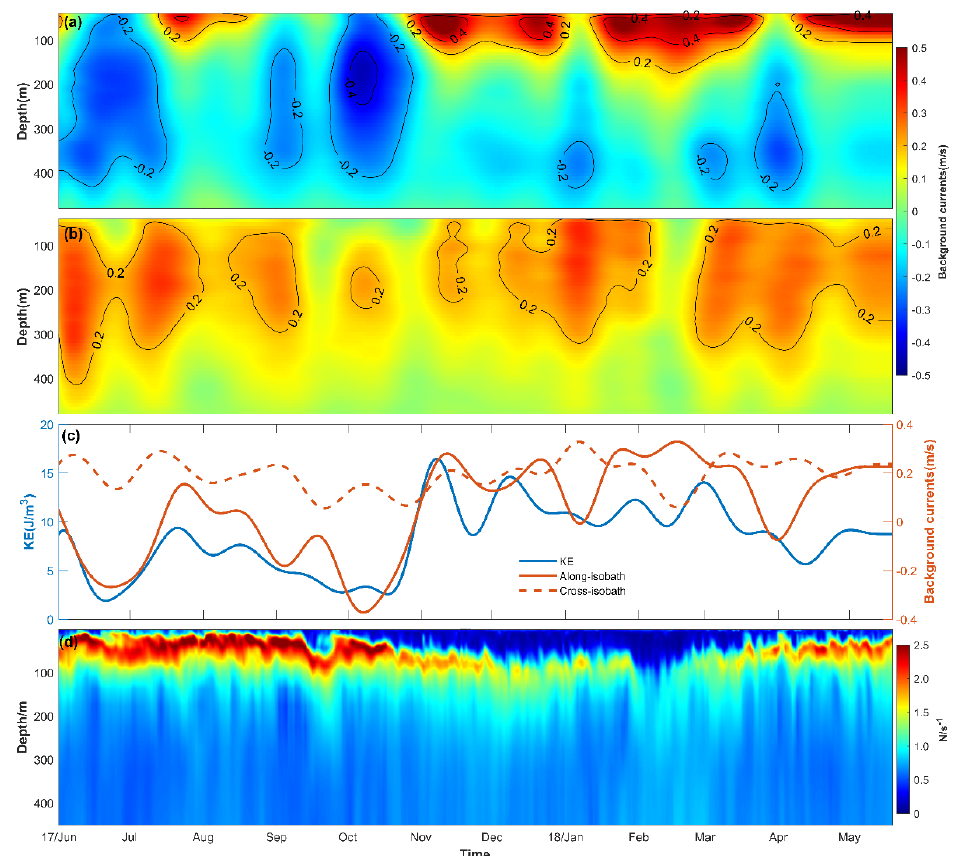
Figure 8. Low-pass filtered ( a ) along-isobath and ( b ) cross-isobath background currents, ( c ) low- pass filtered depth-mean kinetic energy density of the semidiurnal ITs (blue line) and the upper 200 m averaged along-isobath (solid orange line) and cross-isobath (dashed orange line) background currents, and ( d ) the evolution of buoyancy frequency based on the HYCOM dataset. The low-pass filter has a cutoff frequency of 1/30